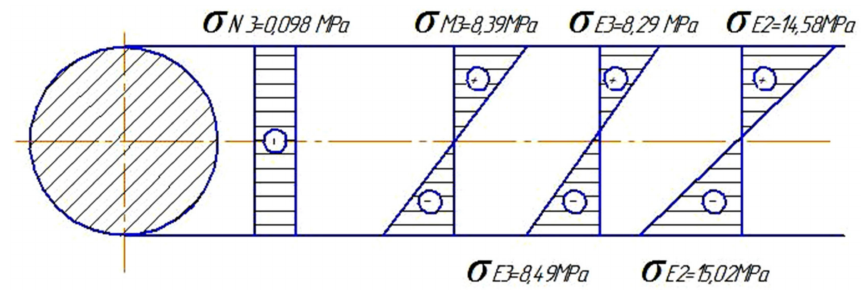
Figure 5. Design scheme with plotting the highest voltages in the cross section of the shaft: σ N3, σ M3, σ E3, σ E2, are stresses in the corresponding shaft